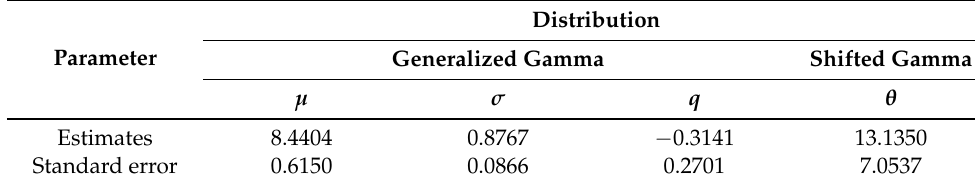
Table 7. Results of parameter estimation when variable selection is performed by applying the proposed model in